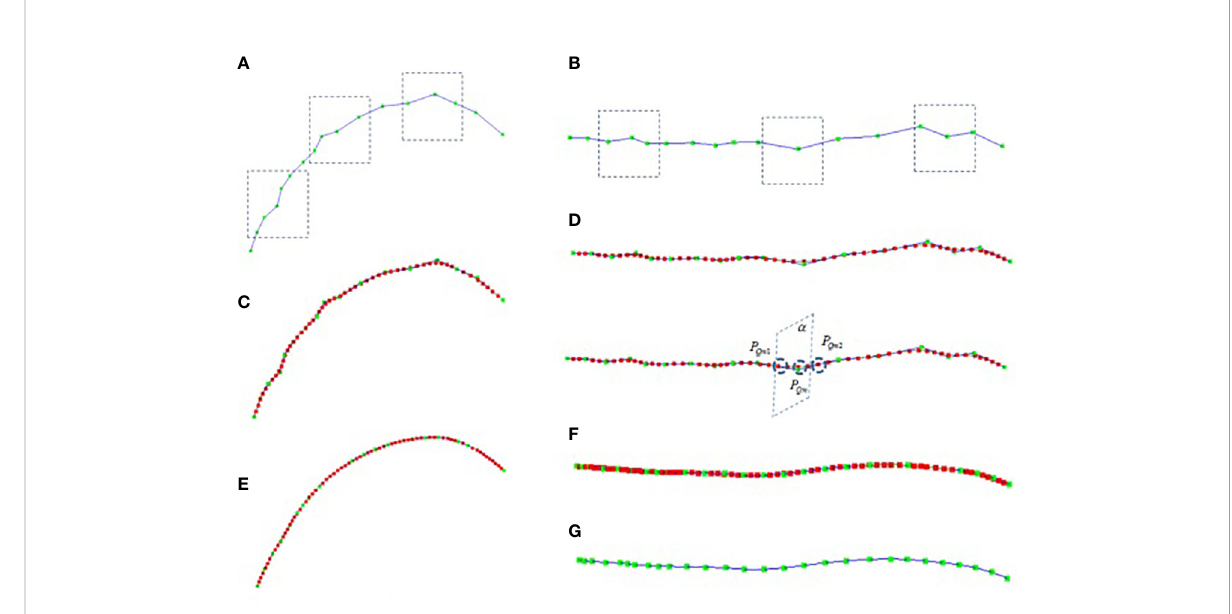
FIGURE 2 Leaf midrib curve smoothing, (A) the front view of collected midrib curve key points, (B) top view of collected midrib curve key points, (C) the front view of midrib curve smoothed based on cubic B-spline, (D) the top view of midrib curve smoothed based on cubic B-spline, (E) the front view of midrib curve smoothed after 8 iterations, (F) the top view of midrib curve smoothed after 8 iterations, (G) the top view of leaf midrib curve after 8 iterations of smoothing (excluding interpolation